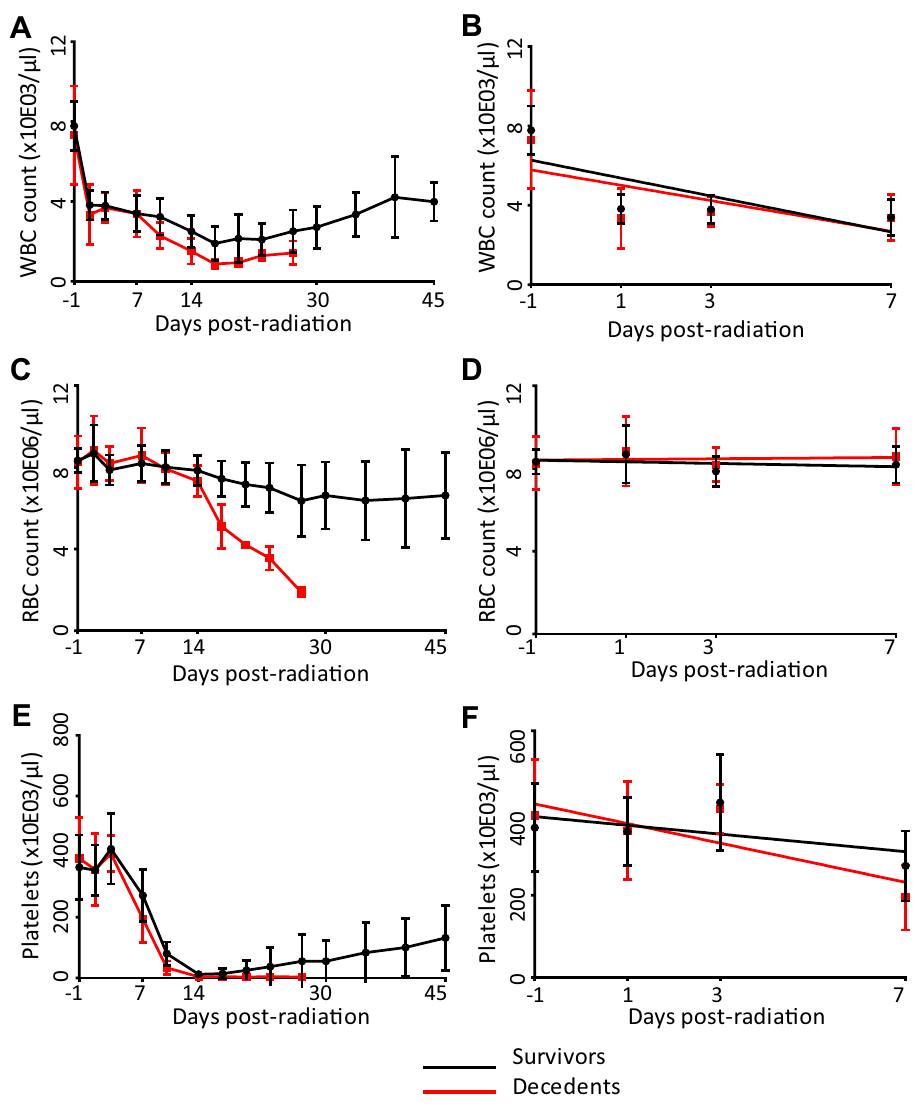
Figure 2. Blood parameters as a function of time in survivors and decedents. Sharp decline was observed in both decedents (red) and survivors (black) over the 45-day period for ( A ) WBC (p < 0.0001), ( C ) RBC (p < 0.0001), and ( E ) platelet counts (p < 0.0001). No significant differences were observed in the decedents and survivors over the 7-day period immediately after radiation in WBC ( B ), RBC ( D ) and platelet ( F )